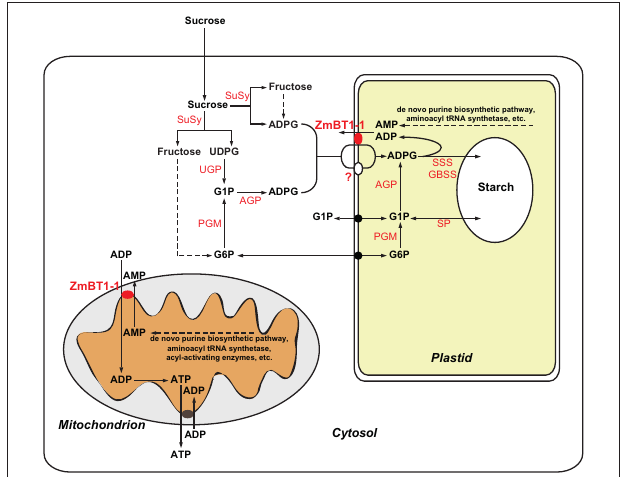
FIGURE 10 | Metabolic scheme illustrating the suggested roles of ZmBT1-1 in the mitochondrion and in the amyloplast of maize endosperms. In amyloplasts, ZmBT1-1 could play a role in facilitating the incorporation of cytosolically produced ADPglucose in exchange for newly synthesized AMP or ADP produced by the starch synthase reaction. In mitochondria, ZmBT1-1 could play a decisive role in exporting AMP to the cytosol in exchange for ADP which, once in the matrix, could be converted to ATP by oxidative phosphorylation. ATP generated in the mitochondrion could be exported to the cytosol by means of the ADP/ATP carrier. GBSS, granule-bound starch synthase; PGM, phosphoglucomutase; SP, starch phosphorylase; UGP, UDP glucose